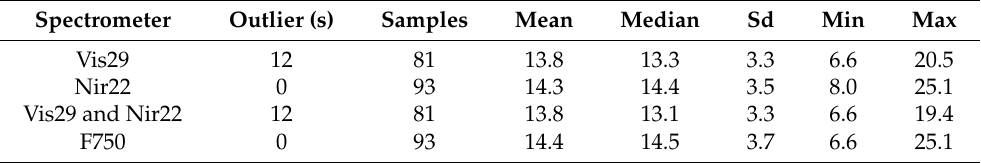
Table 2. Number of outliers and sample statistics. Where applicable, unit % Brix.